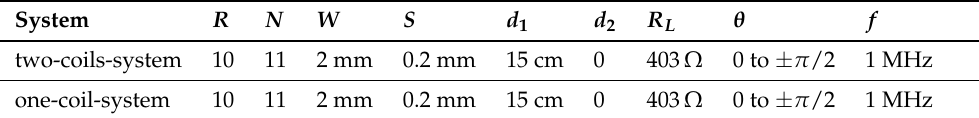
Table 2. Coil Parameters Of one-coil-receiver system and two-coils-receiver system.